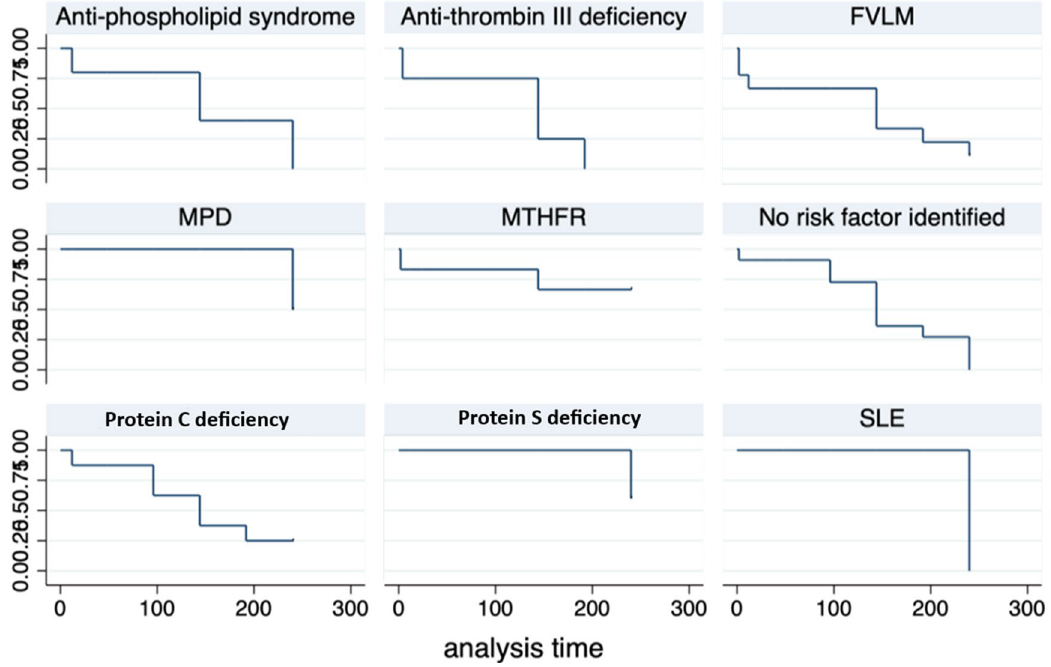
Figure 3. Regression analysis of different risk factors for development of Budd Chiari syndrome for prediction of hepatic vein patency following recanalization. MPD, myeloproliferative disorder; MTHFR, methylene tetrahydrofolate reductase; FVLM, factor V Leiden mutation; SLE, systemic lupus